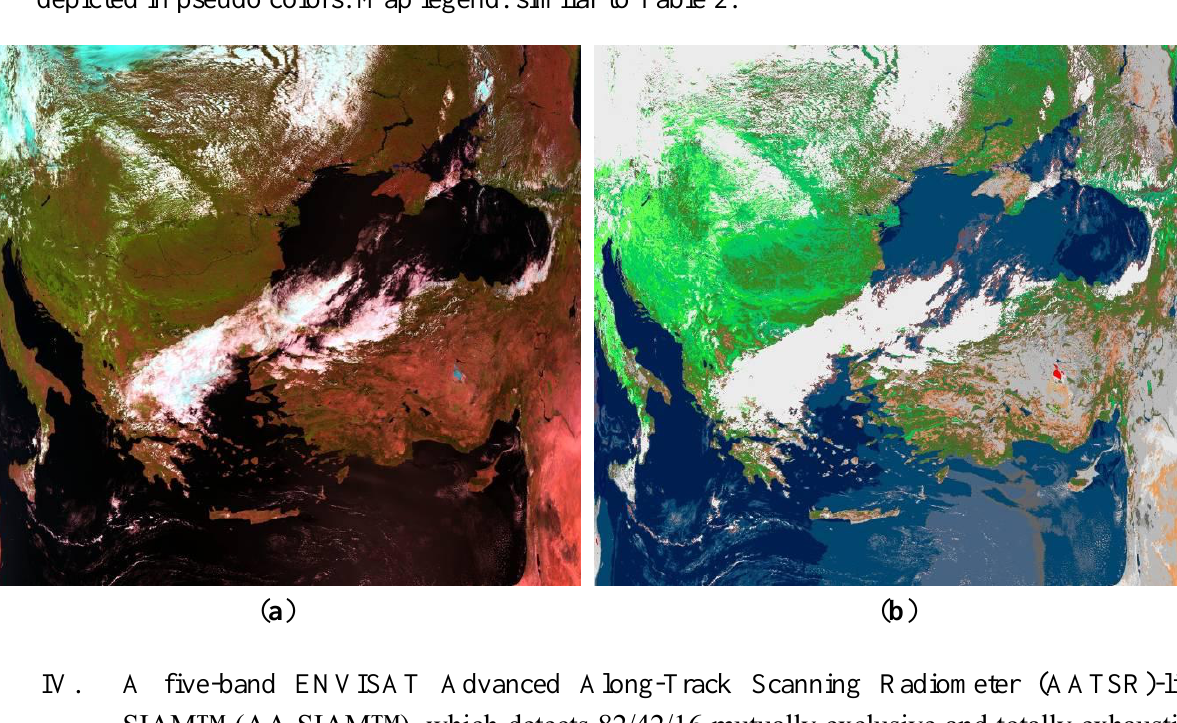
Figure 9. ( a ) NOAA AVHRR (Sat. 17) image acquired on 2005-08-09 covering Turkey, the Balkans and part of Italy (R: band 3a, G: band 2, B: band 1), radiometrically calibrated into TOARF values. The image is in the original, highly non-linear swath projection with spatial resolution at nadir of 1.1 km. ( b ) Preliminary classification map automatically generated by AV-SIAM™ from the image shown in (a). Output spectral categories are depicted in pseudo colors. Map legend: similar to Table